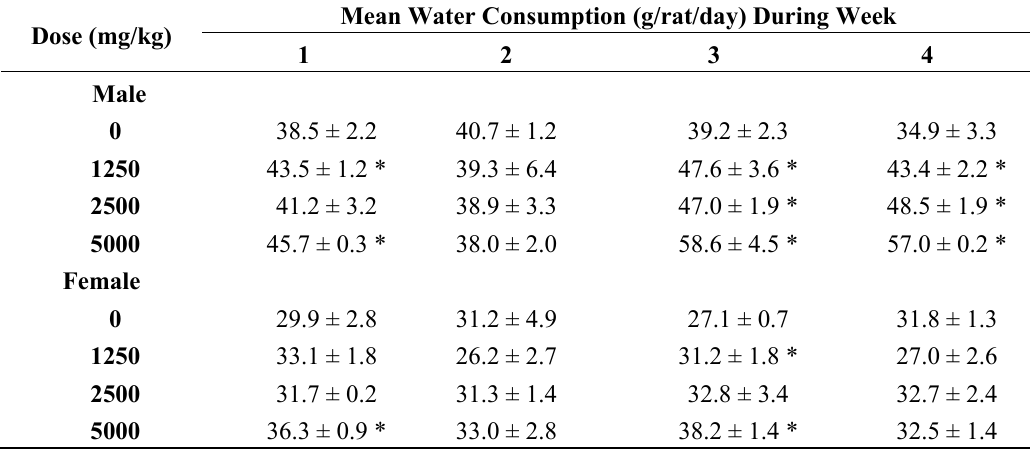
Table 3. Mean water consumption of male and female rats treated with C. setidens for 4 weeks. Mean Water Consumption (g/rat/day) During Week Dose (mg/kg)